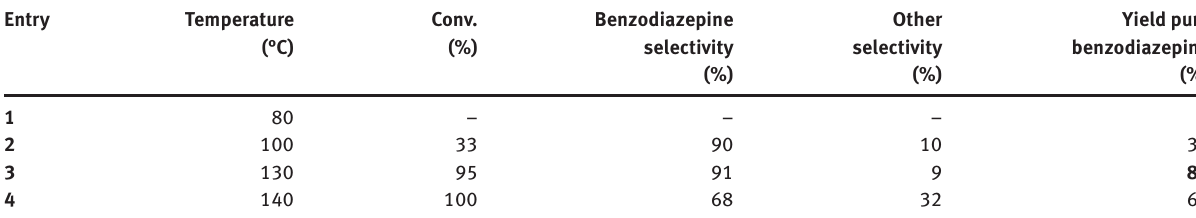
Table 5: Temperature effect for PVA